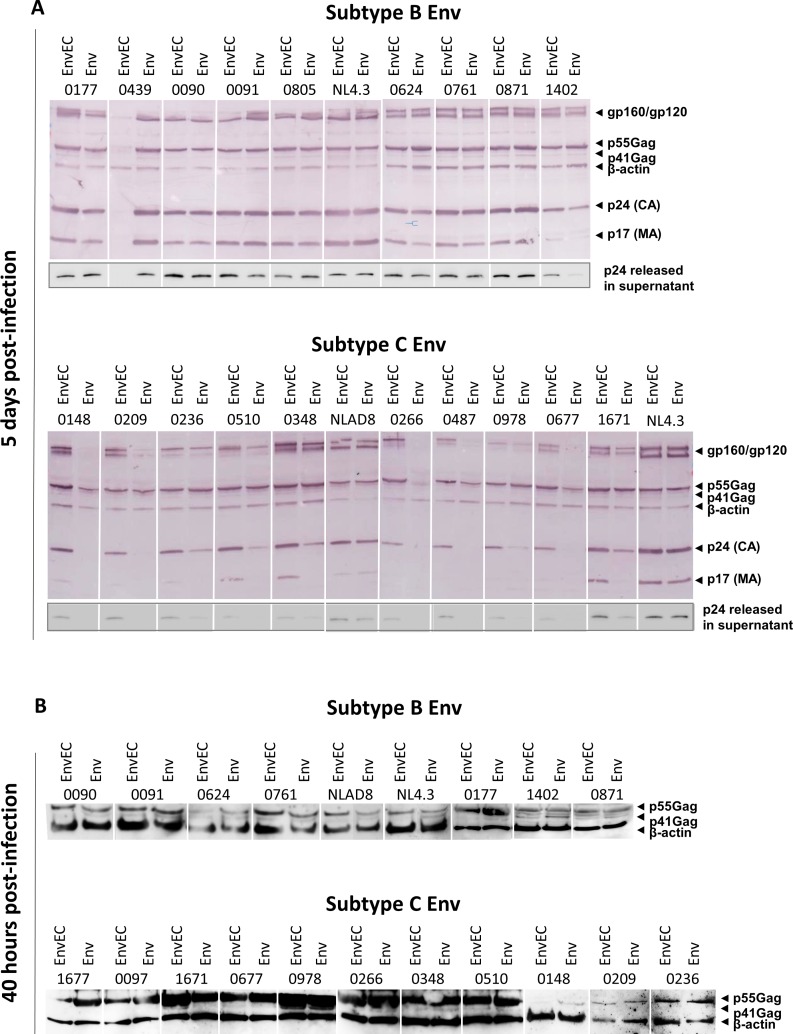
Lower replication of C-Env recombinants in CD4+ T-cells is not associated with lower viral gene expression.A and B. Western Blot analyses of intracellular Env and Gag in CD4+ T-cells exposed to subtype B and subtype C recombinant virus pairs at day 5 post infection (A) and 40 hours post infection (B). CD4+ T-cells (105 cells/well) infected in triplicate wells for 5 days (A) or for 40 hours (B) were washed, pooled and lysed in 75μl of reducing Lämmli buffer. Polybrene was added at the time of infection of C-EnvEC and C-Env virions for WB detection in 40-hour lysates. Proteins were resolved by SDS-PAGE and immunoblotted with a rabbit polyclonal antibody recognizing the immature p55Gag immature precursor and the mature p17 and p24 proteins, and a goat polyclonal antibody against gp120. β-actin was immunoblotted to control for loading. The corresponding supernatant (30 μl) were immunoblotted using a mouse monoclonal antibody against p24. One representative experiment of three is shown. Samples are arranged by subtype to ease visual comparison. C and B Env samples were also run on the same gel, and similar subtype and gp41CT-related differences were observed (not shown).